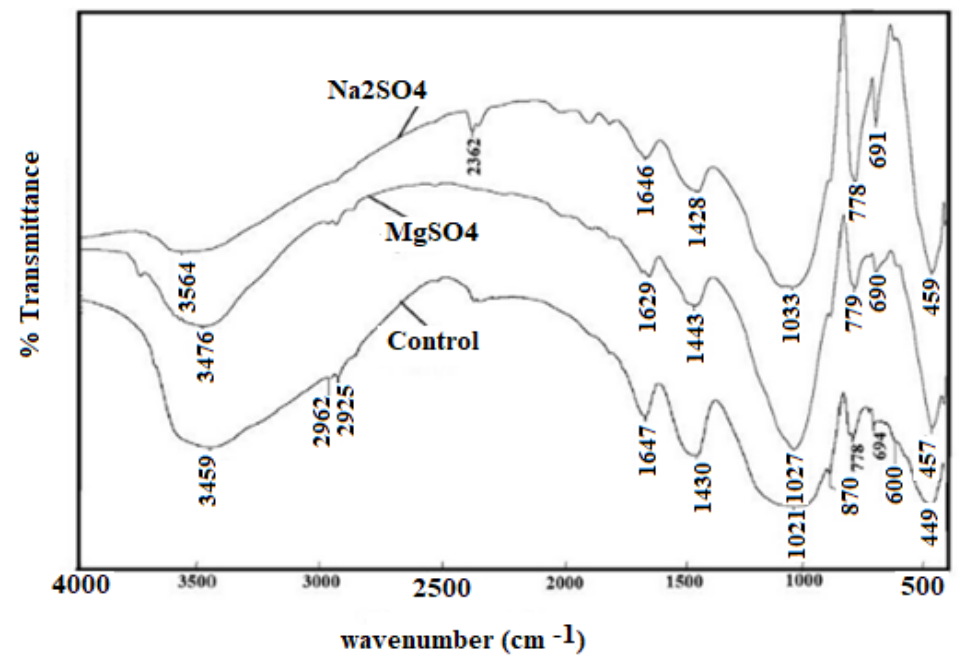
Figure 14. The effect of a sulfate attack on a Si-O-T band (From Elsevier Ref. [28] and used with permission).